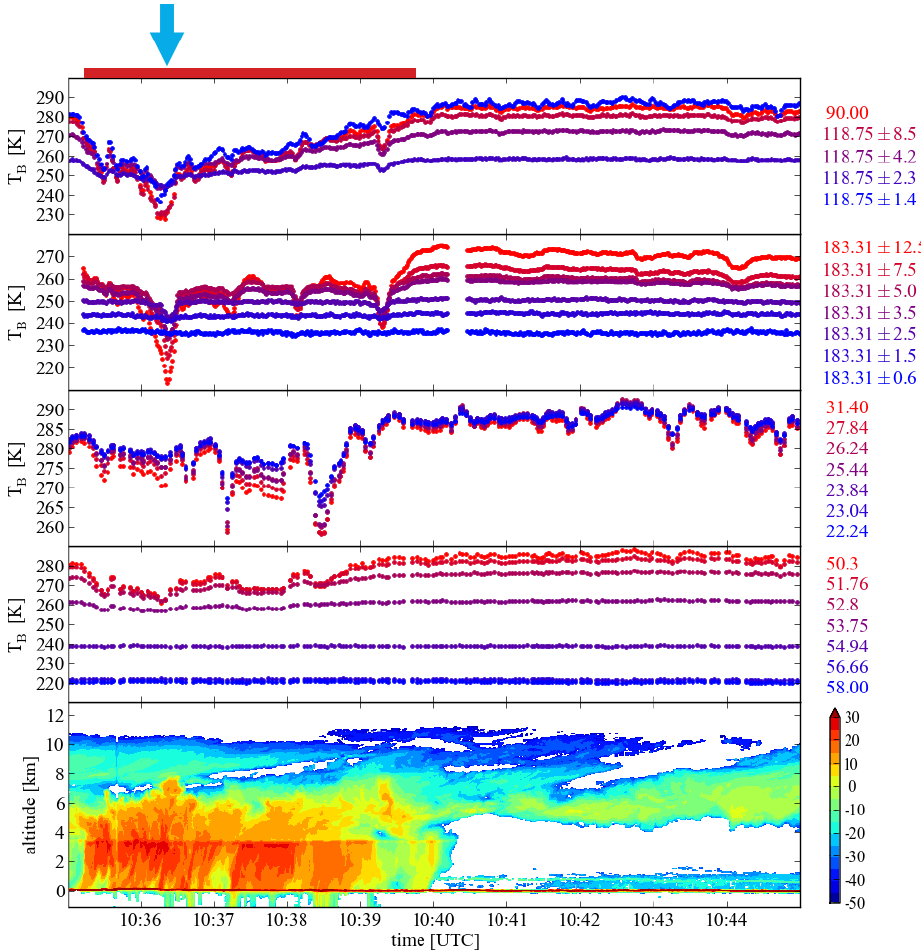
Figure 8. Measurements taken by HAMP on 24 July 2013 over western Germany. The upper four panels show the measurements taken by the radiometer modules. The lower panel shows the reflectivities in dBZ captured by the MIRA-36 cloud radar.